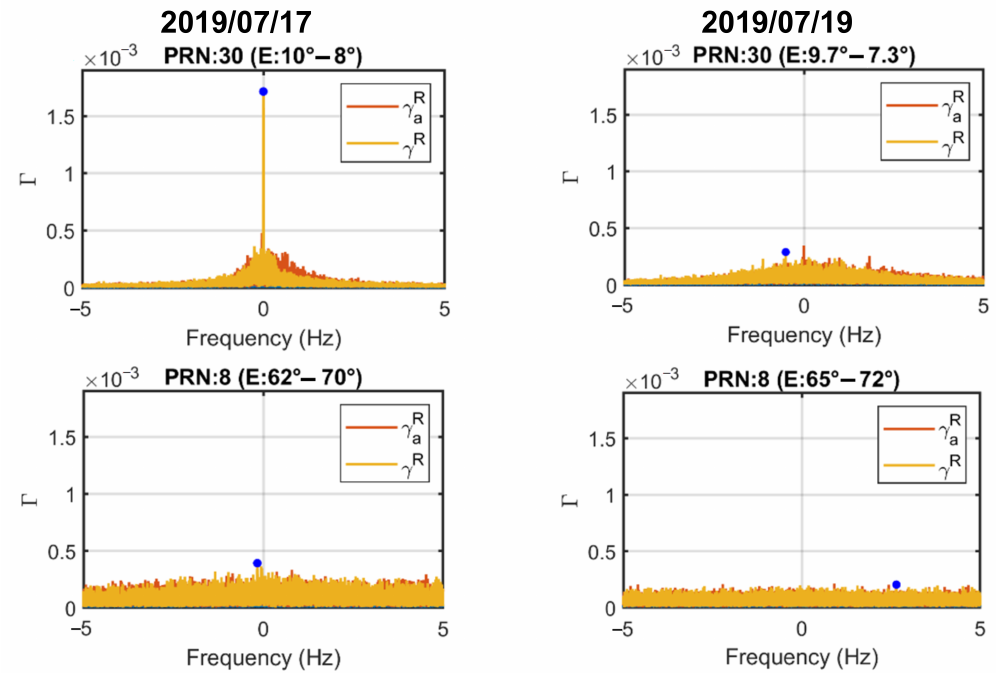
Figure 6. Power spectral density for low- and high-elevation satellites. The blue dot denotes the locations of the peak maxima. The wide distribution of the observed Doppler shift (red line) has been corrected in the retracking step (yellow line), yielding a narrower Doppler shift